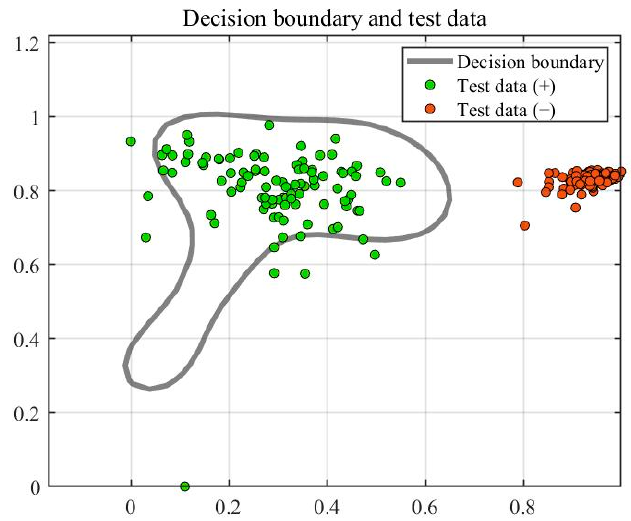
Figure 10. Results of testing.